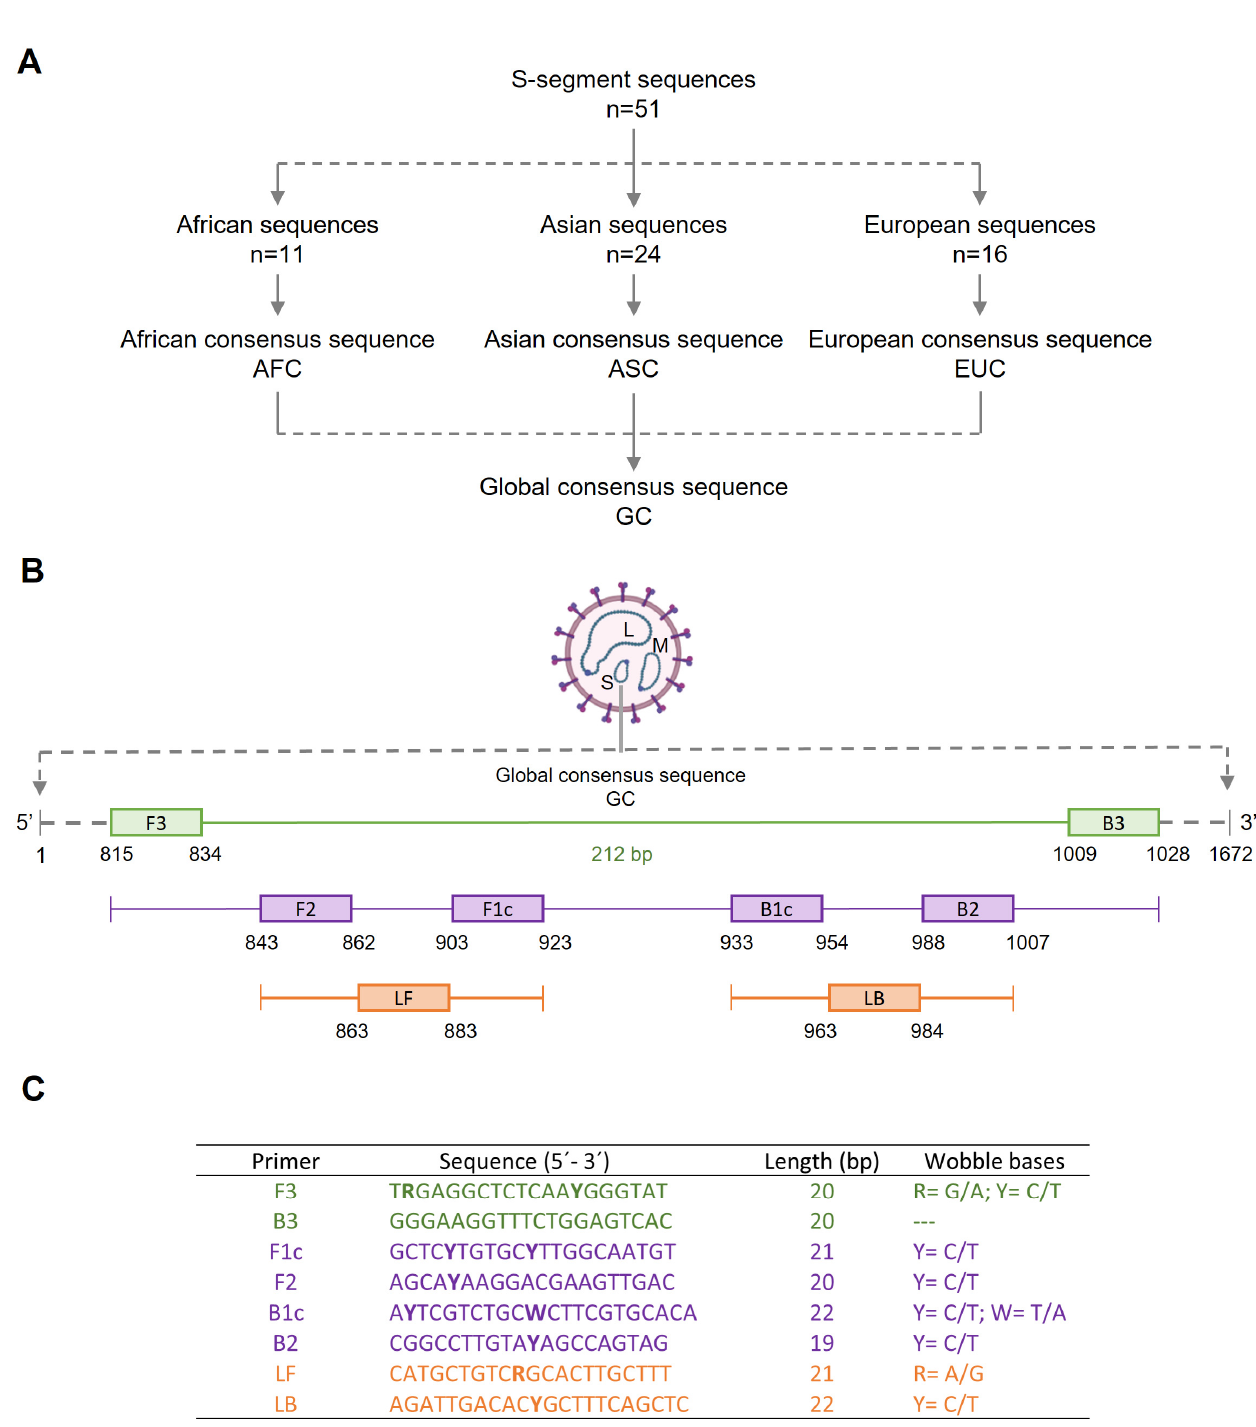
Figure 6. Schematic representation of the process for the design of reverse-transcription loop-mediated isothermal amplification assay (RT-LAMP) for CCHFV. ( A ) Outline for global consensus (GC) sequence selection based on several linear single-strand RNA S-segments from CCHFV. ( B ) Outline of location of set of primers in the partial GC sequence used as target. ( C ). Sequences of the RT-LAMP primers finally selected. F3, forward primer; B3, backward primer: F1c + F2 sequences: FIP, forward inner primer; B1c + B2 sequences: BIP, backward inner primer; LF, loop forward primer; LB, loop backward primer. Bold letter codes (R, Y or W) are used to represent the combination of two different nucleotide phosphoramidites blended at equimolar ratios prior to coupling at that position in the sequence.